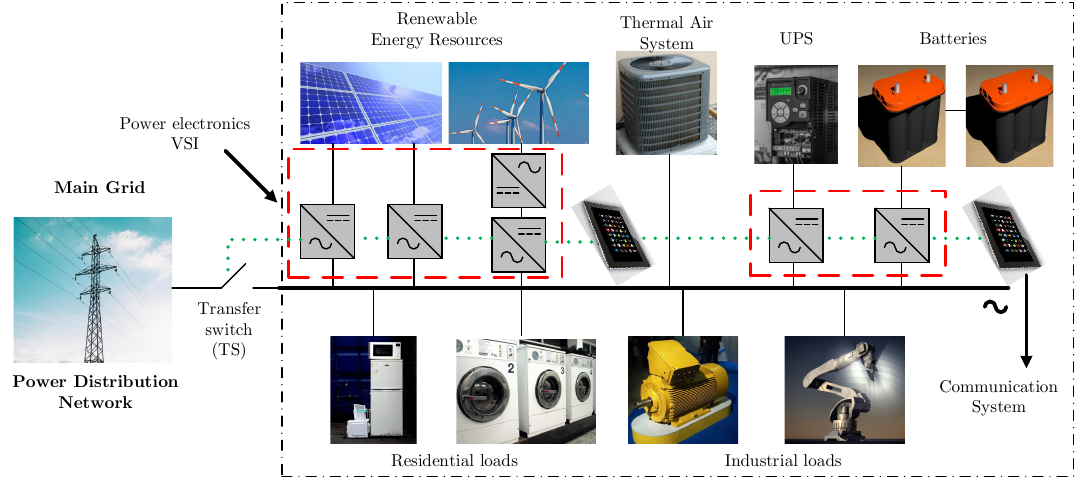
Figure 3. Microgrid scheme from inverter-based sources